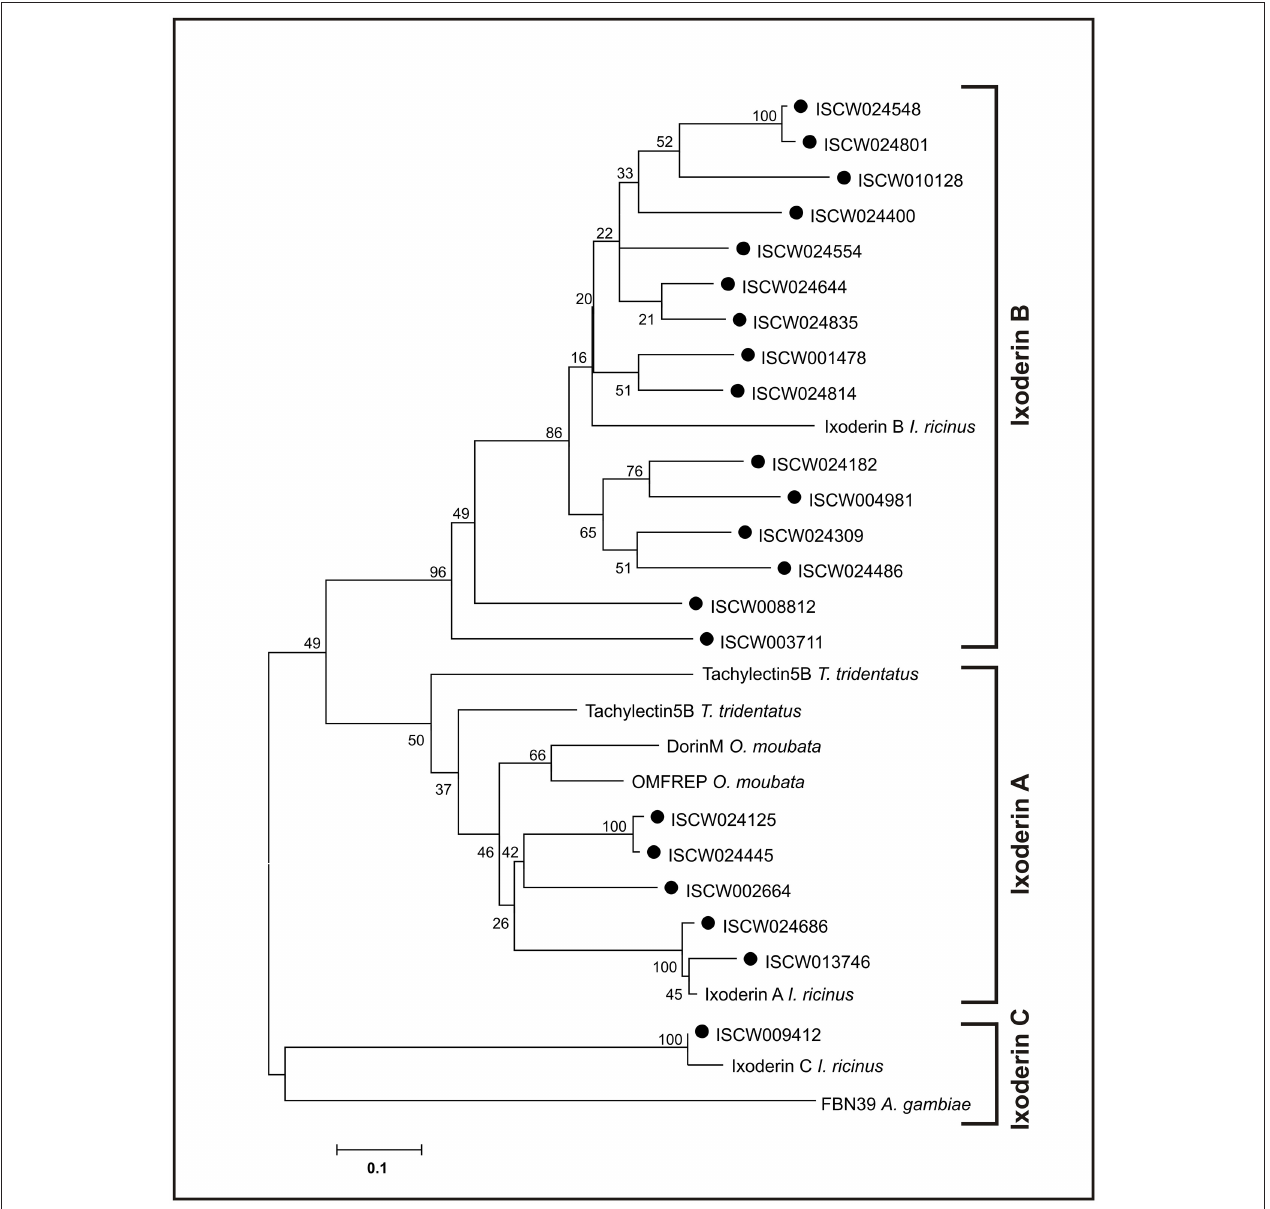
FIGURE 1 | Tick FRePs cluster into three groups designated as Ixoderin A, B, and C. An unrooted phylogenetic tree of the tick and related invertebrate FReP amino acid sequences, reconstructed using the Neighbor Joining (NJ) method and based on alignment using ClustalX. Full circles indicate genomic ixoderin sequences of I. scapularis . Numbers at branches represent bootstrap support using NJ criterion with 1,000 replicates each. Bar: 0.1 substitutions per site. Ixoderin A I. ricinus : AAQ93650 (AY341424), Ixoderin B I. ricinus : AAV41827 (AY643518), Ixoderin C I. ricinus : GCJO01000224. Alignment and full sequence descriptions are provided as Supplementary Data Sheet 1 and